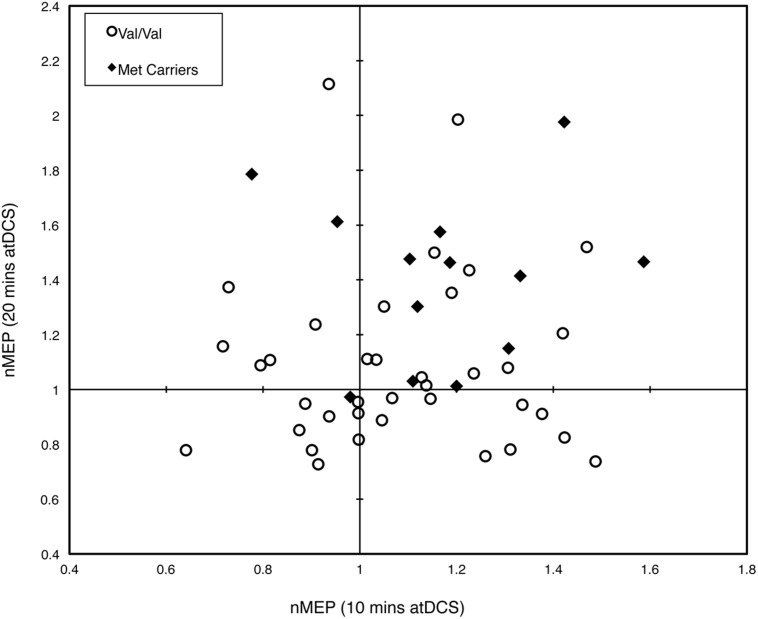
Intra-subject variability in response to different durations of atDCS. Scatter plot of normalized MEP amplitude averaged over all post-stimulation time points after 10 min of atDCS (abscissa) and after 20 min of atDCS (ordinate) for each participant. Participants are grouped by BDNF genotype, either Val/Val homozygotes (empty circles) or Met carriers (filled diamonds). nMEP > 1 represents facilitation, nMEP < 1 indicates suppression.